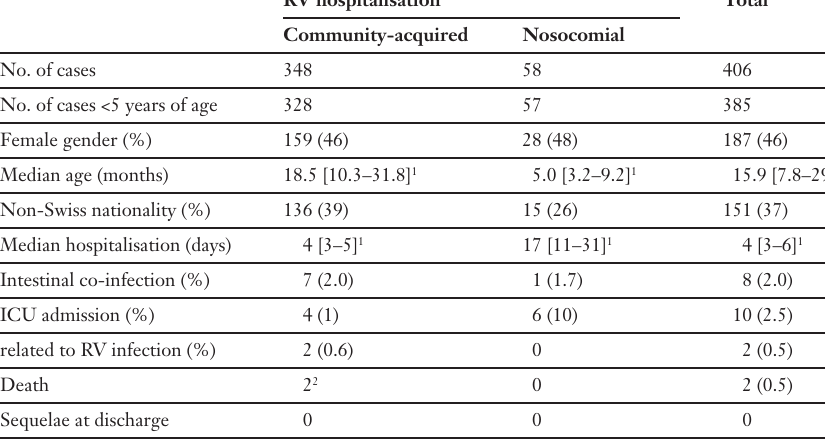
were calculated for community-acquired cases (table 3). The number of child-years listed for each age group was derived from the annual live birth rates from 1995 to 2003 (mean, 8755; range, 7774–9613). The cumulative risk of RV hospitali- sation by the age of 4 and 5 years was 1:143 and 1:132 respectively. For comparison, hospitalisa- tion incidences for RSV infection, the single most common viral aetiology of hospital admission in young children, are also listed [16]. The overall hospitalisation incidences for RV and RSV in chil-